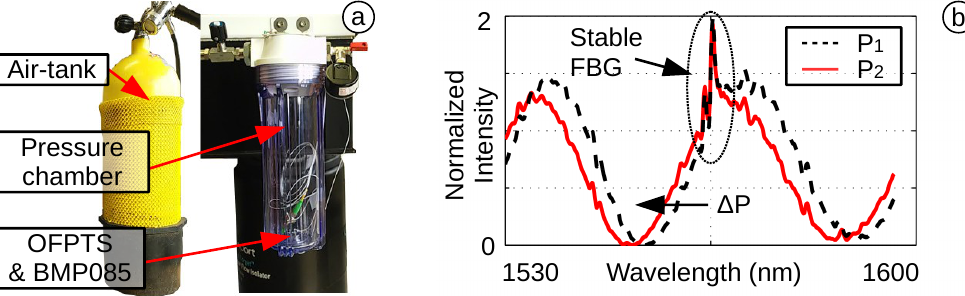
Figure 12. ( a ) Pressure chamber up to 10 bar; ( b ) FPI spectrum with stable